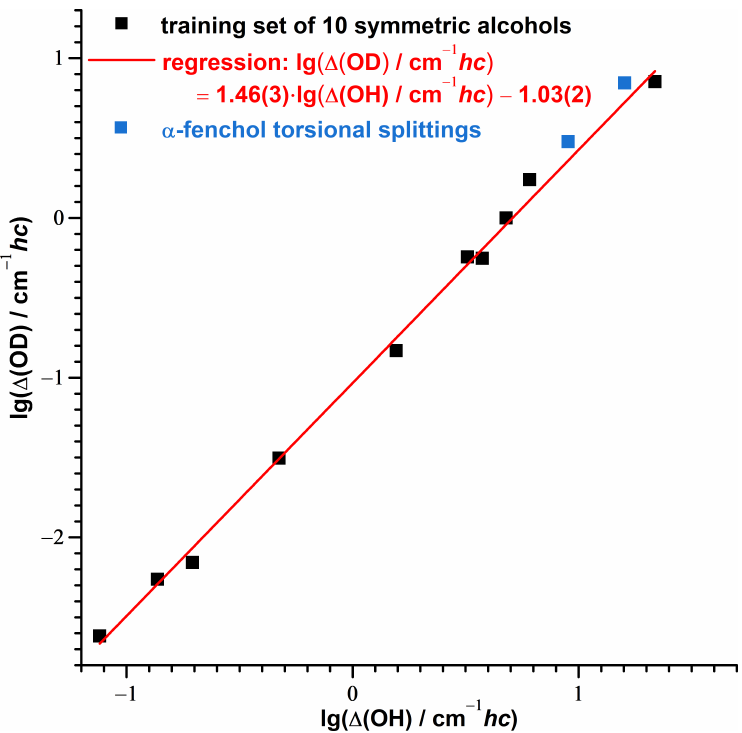
Figure 8. Correlation between the logarithmized experimental tunneling splittings lg ( ∆ /cm − 1 hc ) of deuterated and protiated symmetric alcohols (Direct Correlation Model of Ref. [93], details given there) compared with the torsional splittings assigned for the ground and the OH/OD stretch excited state of α -fenchol.